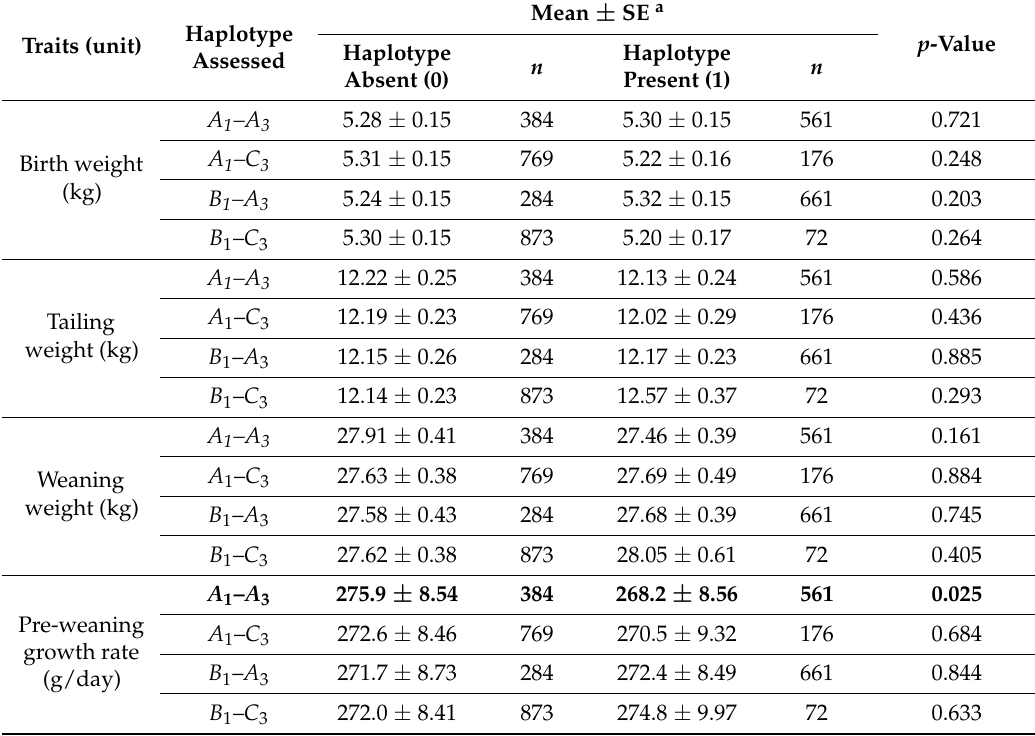
Table 1. Association of ovine adiponectin gene ( ADIPOQ ) haplotypes with growth traits in NZ Romney